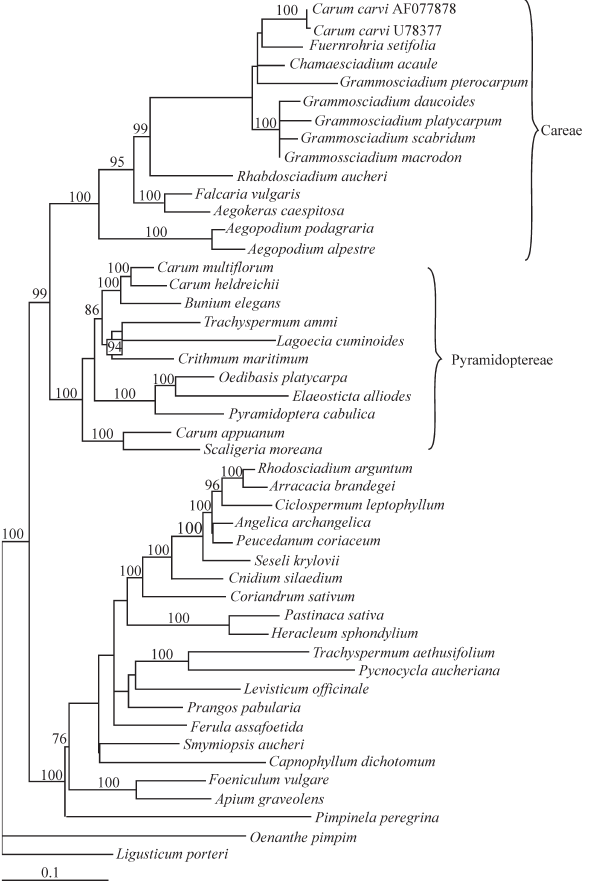
Figure 1 - Maximum likelihood tree with Bayesian support reported above